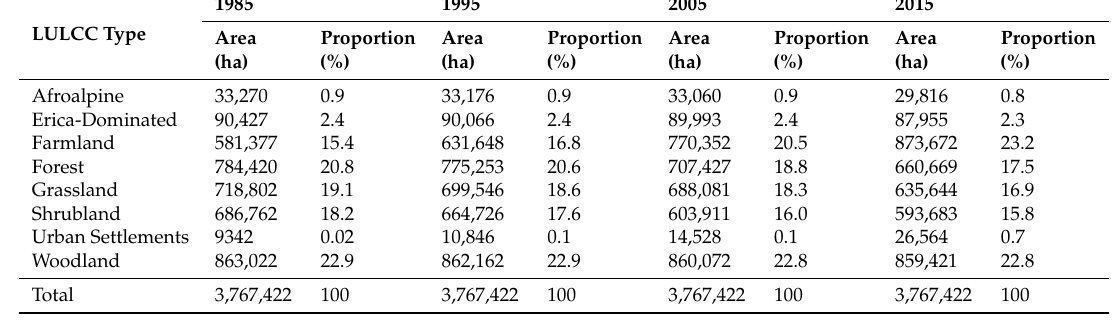
Table 3. Area and proportion of LULC in BMER in 1985, 1995, 2005, and 2015.